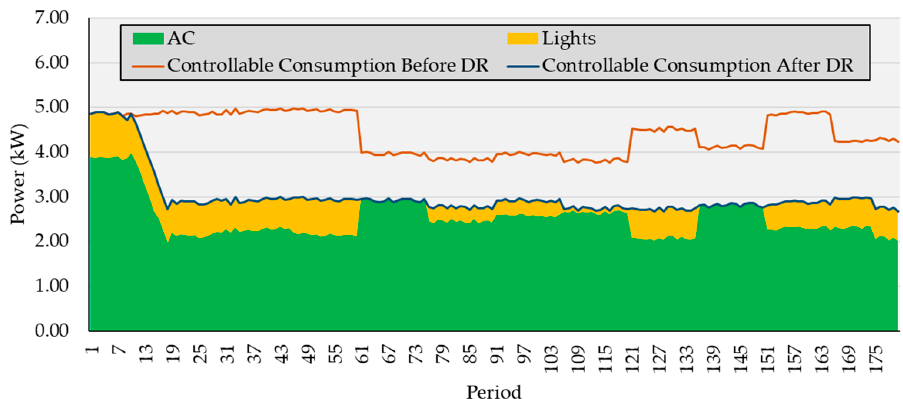
Figure 10. Consumption reduction in the commercial building during ramping of DR event.